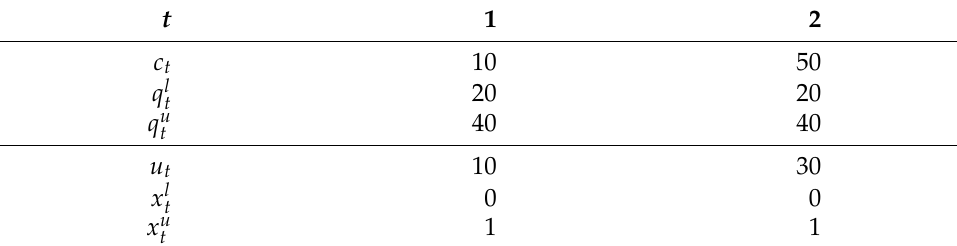
Table 1. Data for Example